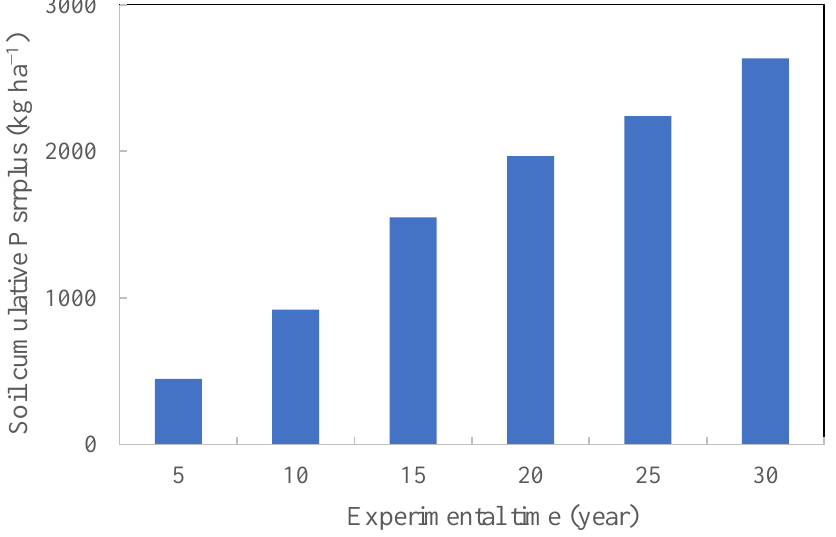
Figure A3. Cumulative P surplus over time in 91 experiment sites. The experimental time (year) 5, 10, 15, 20, 25, and 30 refer to the time periods of 1988 – 1992, 1993 – 1997, 1998 – 2002, 2003 – 2007, 2008 – 2012, and 2013 – 2018, respectively.